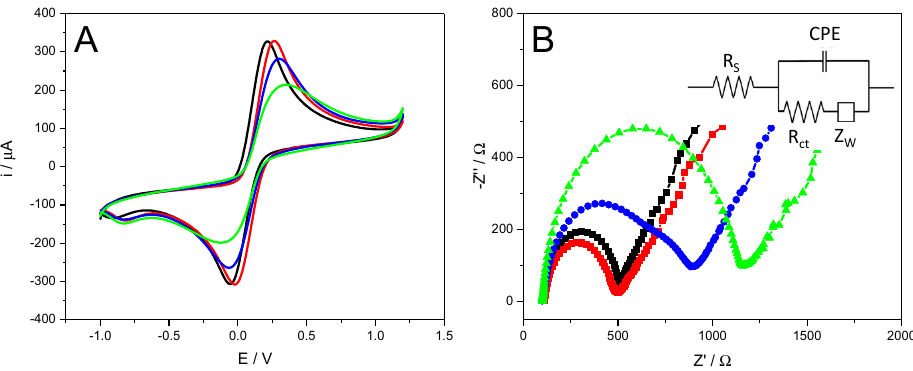
Figure 5. ( A ) CV and ( B ) EIS behaviors of CSPE (black curve), CSPE/MoS 2 -NS (red curve), CSPE/MoS 2 -NS/Apt-SH (blue curve) and CSPE/MoS 2 -NS/Apt-SH/BSA (green curve) in 10 mM Fe(CN) 63 − and 10 mM Fe(CN) 64 − in 0.1 M PB pH 7.